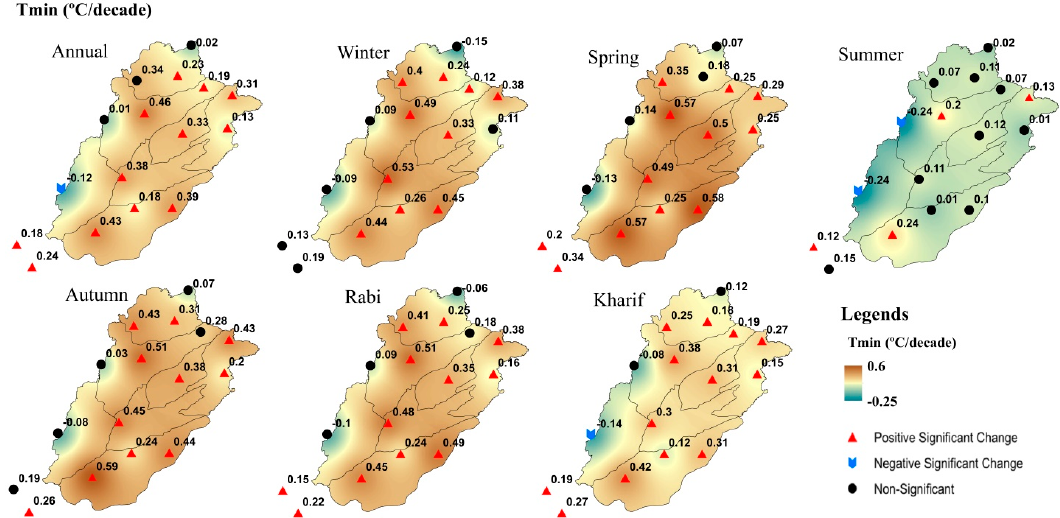
Figure 4. Change per decade and signs of trends at meteorological stations for T min for the year, winter, spring, summer, autumn, Rabi, and Kharif in Punjab for the period 1967–2017 . The spatial distribution of the annual and seasonal trends in T min is presented in Figure 4. The spatial MK trends of the annual T min revealed a clear tendency of warming over the entire Punjab basin except at the Barkhan station, which exhibited a significant decreasing trend with a magnitude of 0.46 °C/decade. For the winter season, the T min revealed a clear increasing tendency, except for the insignificant decreasing trend in the T min at the Murree and Barkhan stations. Table 3. Annual and seasonal MK temperatures trend (°C/decade) indices and precipitation (mm/decade) in Punjab Province during 1967–2017 using Mann–Kendall and Sen’s slope.